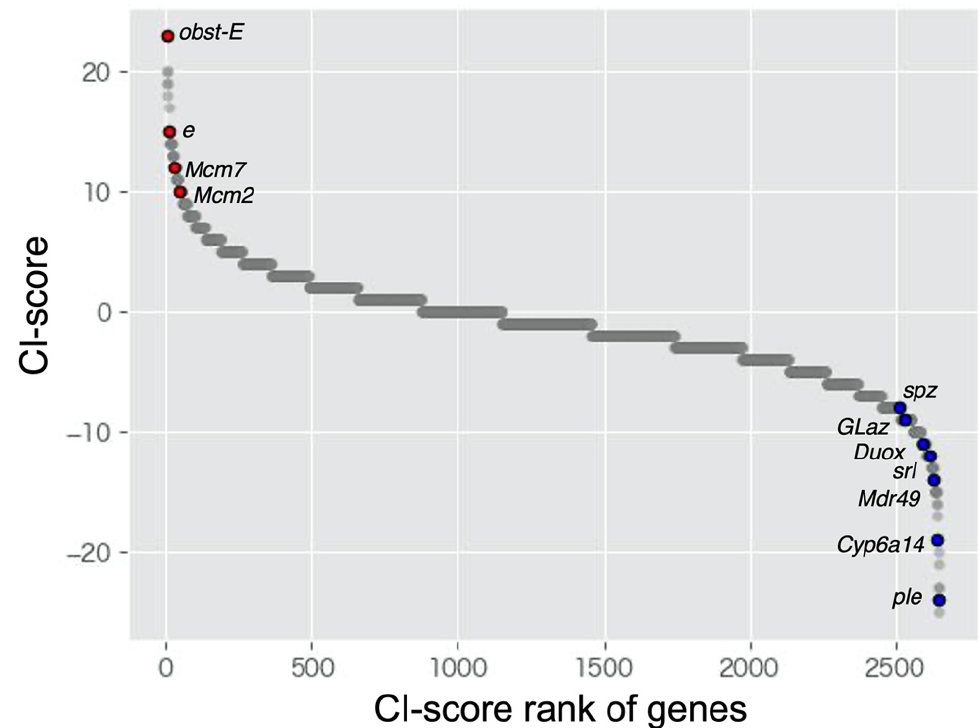
Figure 1. Scatter plots of CI-score of all genes (2652 genes) identified in this study. The red and blue dots indicate genes that have been identified in the previous studies as the differentially expressed genes between crowded and isolated conditions.